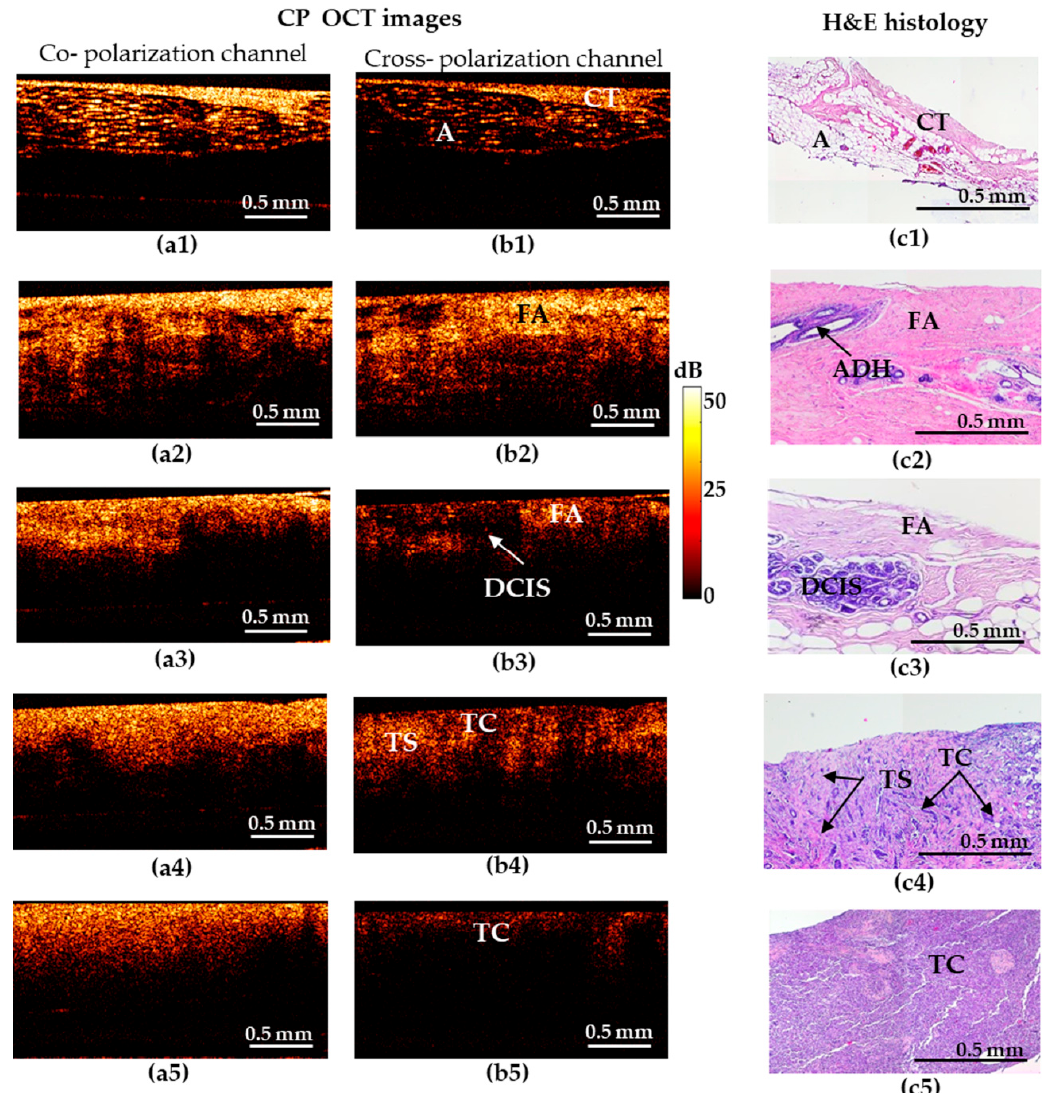
Figure 1. Representative depth-wise co- and cross-polarization OCT images ( a , b ) of non-tumorous and tumorous breast tissue with the corresponding histology ( c ). ( a1 – c1 ) Adipose tissue with streaks of connective tissue; ( a2 – c2 ) fibroadenomatosis/fibroadenoma; ( a3 – c3 ) DCIS; ( a4 – c4 ) invasive ductal carcinoma (IDC) of scirrhous structure (low-aggressive breast cancer subtype); ( a5 – c5 ) IDC of